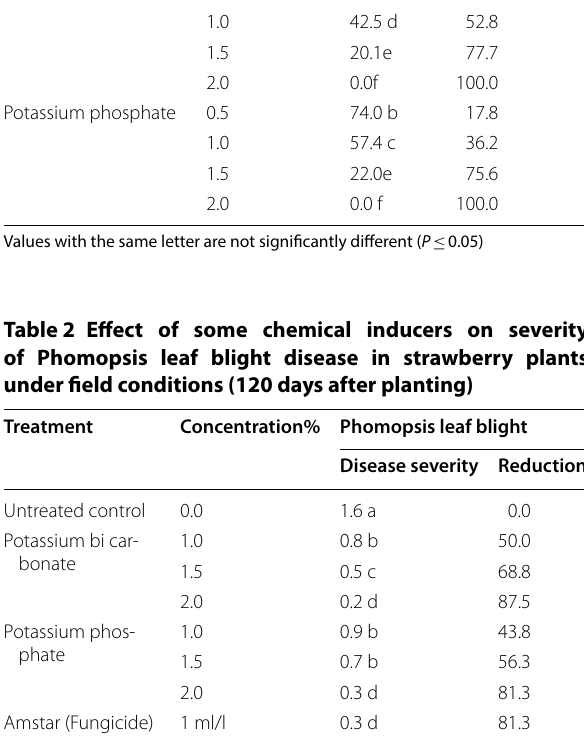
Untreated control Potassium bicarbonate 0.5